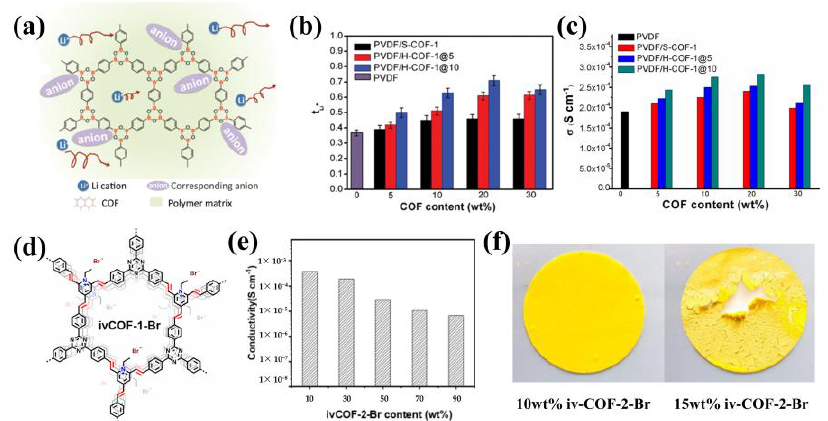
Figure 15. ( a ) Schematic diagram representing the anion adsorption capacity of boron − containing COFs; ( b ) Ionic conductivity of the electrolytes with different COF contents; ( c ) tLi + of the electrolytes with different COF contents. Reproduced with permission from Ref. [77], Copyright (2019), Royal Society of Chemistry; ( d ) Structure of ivCOF − 1 − Br; ( e ) Conductivity of the composite pellets of Li/PEO@ivCOF − 2 − Br with COF contents from 10 wt% to 90 wt%; ( f ) Digital photographs of the composite films Li/PEO@ivCOF − 2 − Br with 10 wt% and 15 wt% ivCOF − 2 − Br contents, respectively. Reproduced with permission from Ref. [79], Copyright (2021), John Wiley and